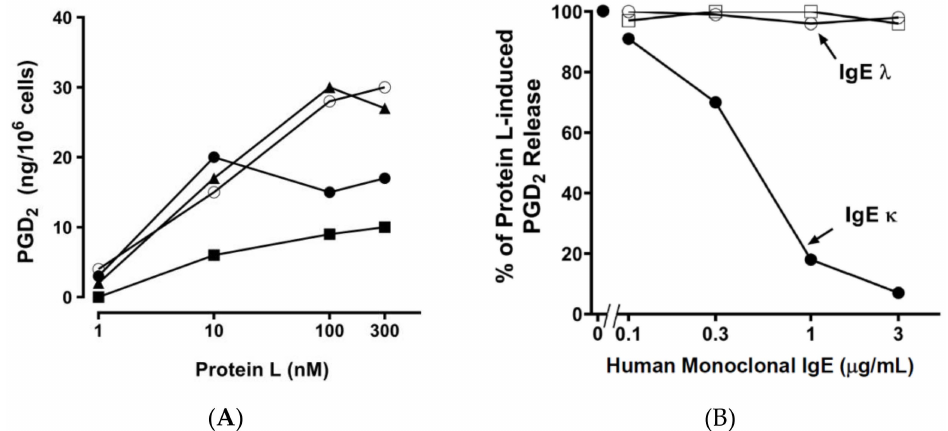
Figure 4. ( A ) E ff ect of increasing concentrations of protein L on the de novo synthesis of prostaglandin D 2 (PGD 2 ) from four di ff erent preparations of HHMCs. HHMCs were incubated (45 min at 37 ◦ C) with the indicated concentrations of protein L. Each point shows the mean of duplicate determinations. Each symbol represents the results from an individual donor. ( B ) E ff ect of preincubation of protein L with human monoclonal IgE on the activation of HHMCs. Protein L (100 nM) was preincubated (15 min at 37 ◦ C) with increasing concentrations (0.1 to 3 µ g / mL) of two human monoclonal IgE λ light chain and one human monoclonal IgE κ light chain and incubation continued for another 45 min at 37 ◦ C. Each point shows the mean of duplicate determinations of PGD 2 of a representative experiment. Similar results were obtained in two other